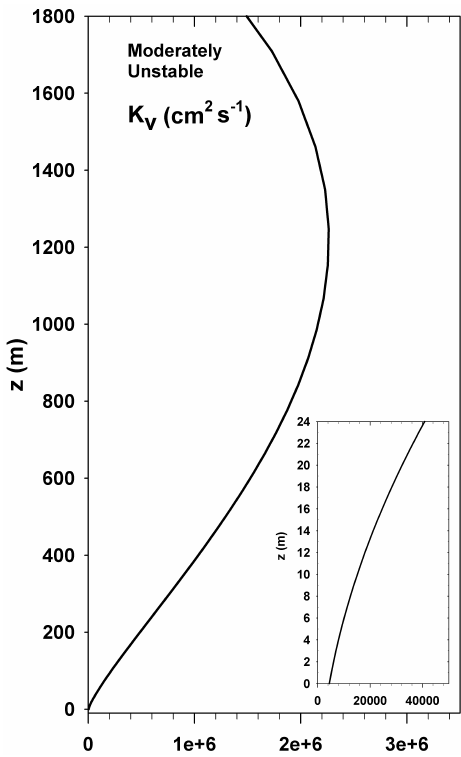
Fig. 3. Eddy diffusivity profile (moderately unstable, h/L = − 10) used in the Walker Branch Watershed forest canopy simulation for mid-July, 02:00p.m.LT (cm 2 s − 1 ) . Inset presents K v profile within the canopy.